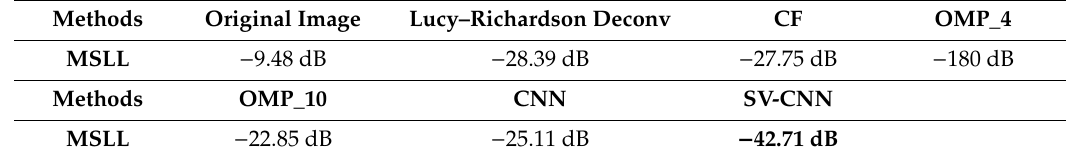
Table 2. MSLL comparison of the above di ff erent methods on simulated images.